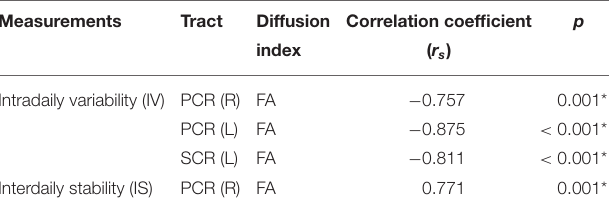
TABLE 3 | Correlations of diffusion indices and actigraphy in SCD ( N = 15), significance at p < 0.01. Measurements Tract Diffusion Correlation coefficient